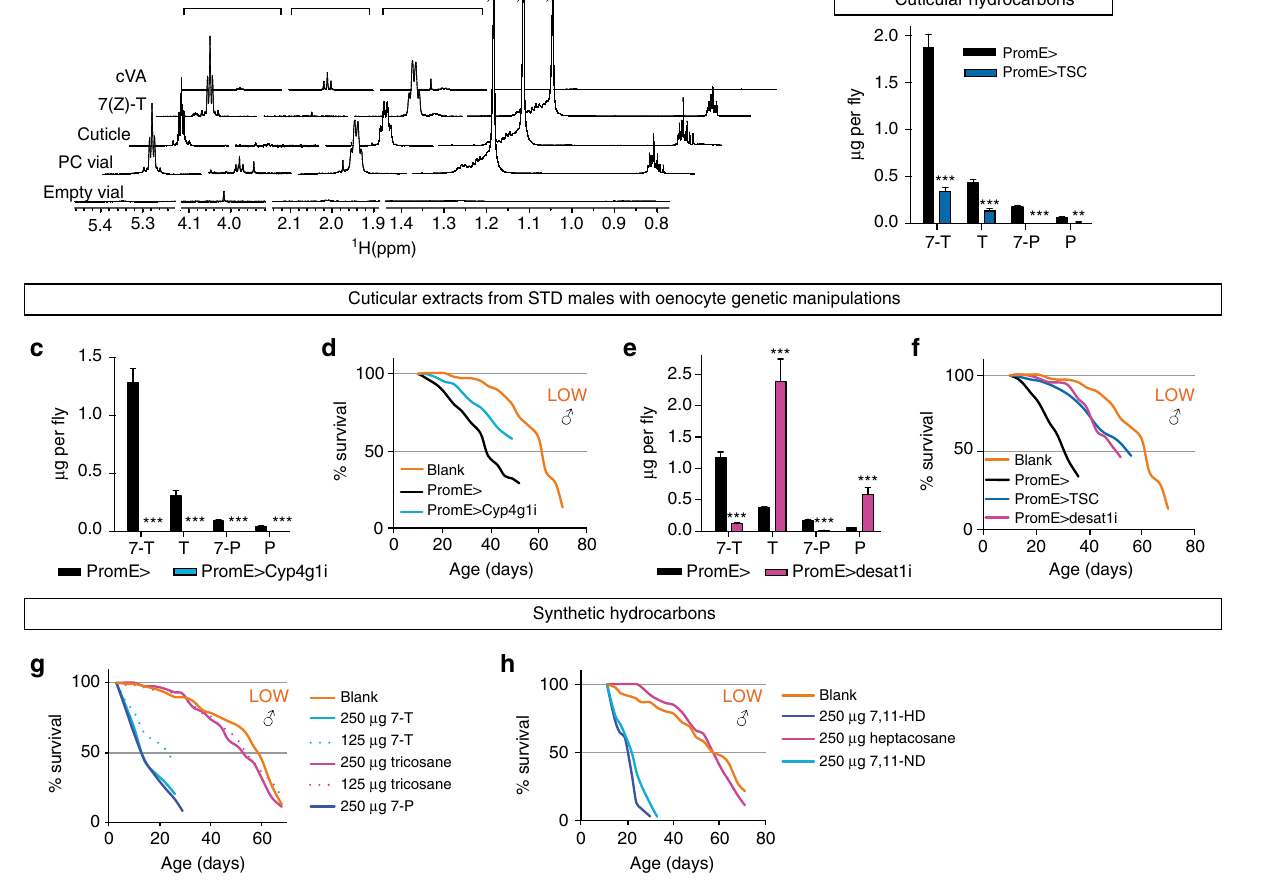
Fig. 6 Cuticular alkenes but not alkanes are autotoxic. a 1 H NMR pro fi les showing that hexane extracts of STD males (Cuticle) and HYHG vials preconditioned with STD males (PC Vial) contain large quantities of 7(Z)-tricosene (7(Z)-T). Pro fi les from synthetic 7(Z)-T), cis -vaccenyl acetate (cVA) and non-preconditioned vials are shown for comparison. b – f Adult oenocyte genetic manipulations decrease major cuticular hydrocarbons measured by GC – MS ( n = 6) b , c , e and also decrease the autotoxic activity of cuticular extracts d , f . Genotypes are as indicated and STD adult males were aged for 3 weeks on HYHG b , e , f or for 1 week on STD adult diet c , d . Blank curves are the same in d , f , as these experiments were done in parallel. g , h Synthetic cuticular alkenes but not alkanes of equivalent chain lengths display autotoxic activity. In d , f – h 15 LOW responder males per HYHG vial were used. For b – e : ** p < 0.01, *** p < 0.001, two-way ANOVA followed by the Bonferroni multiple comparisons test. Error bars show 1